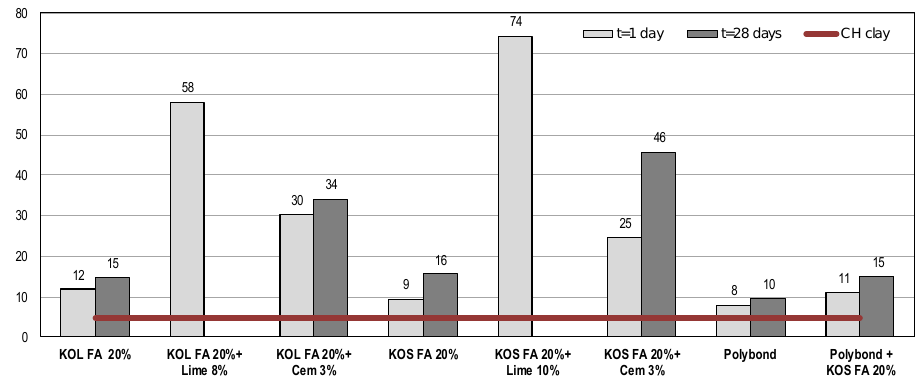
Figure 6. The California bearing ratio of di ff erent mixtures with CH